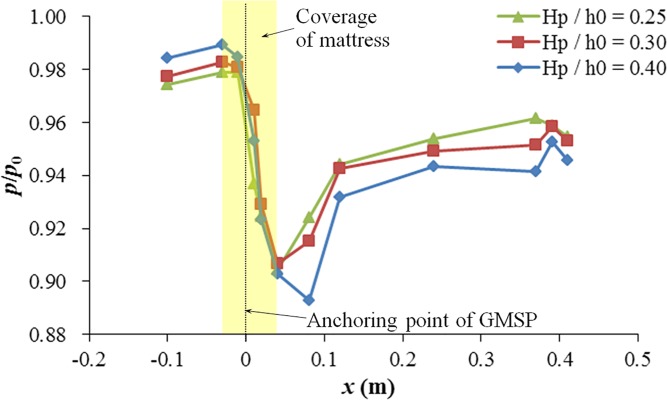
Bed pressure distribution on two sides of the GMSP for different relative plate heights.